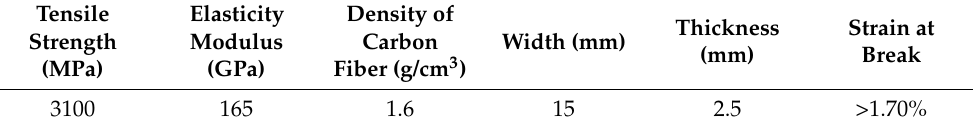
Table 2. The mechanical and physical properties of the NSM-CFRP strip by Sika Company.